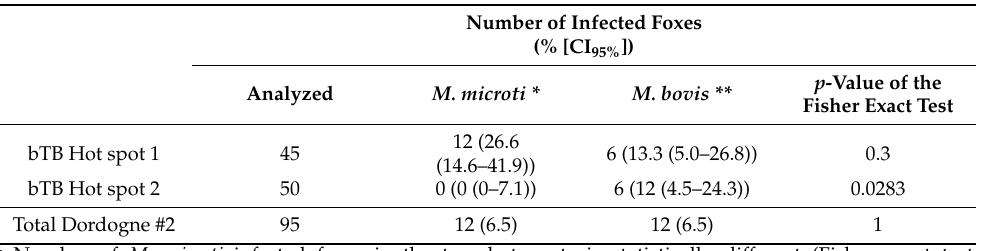
Table 2. Results of M. microti and M. bovis detection in foxes in Dordogne (season #2) and in the two bTB hot spots of this